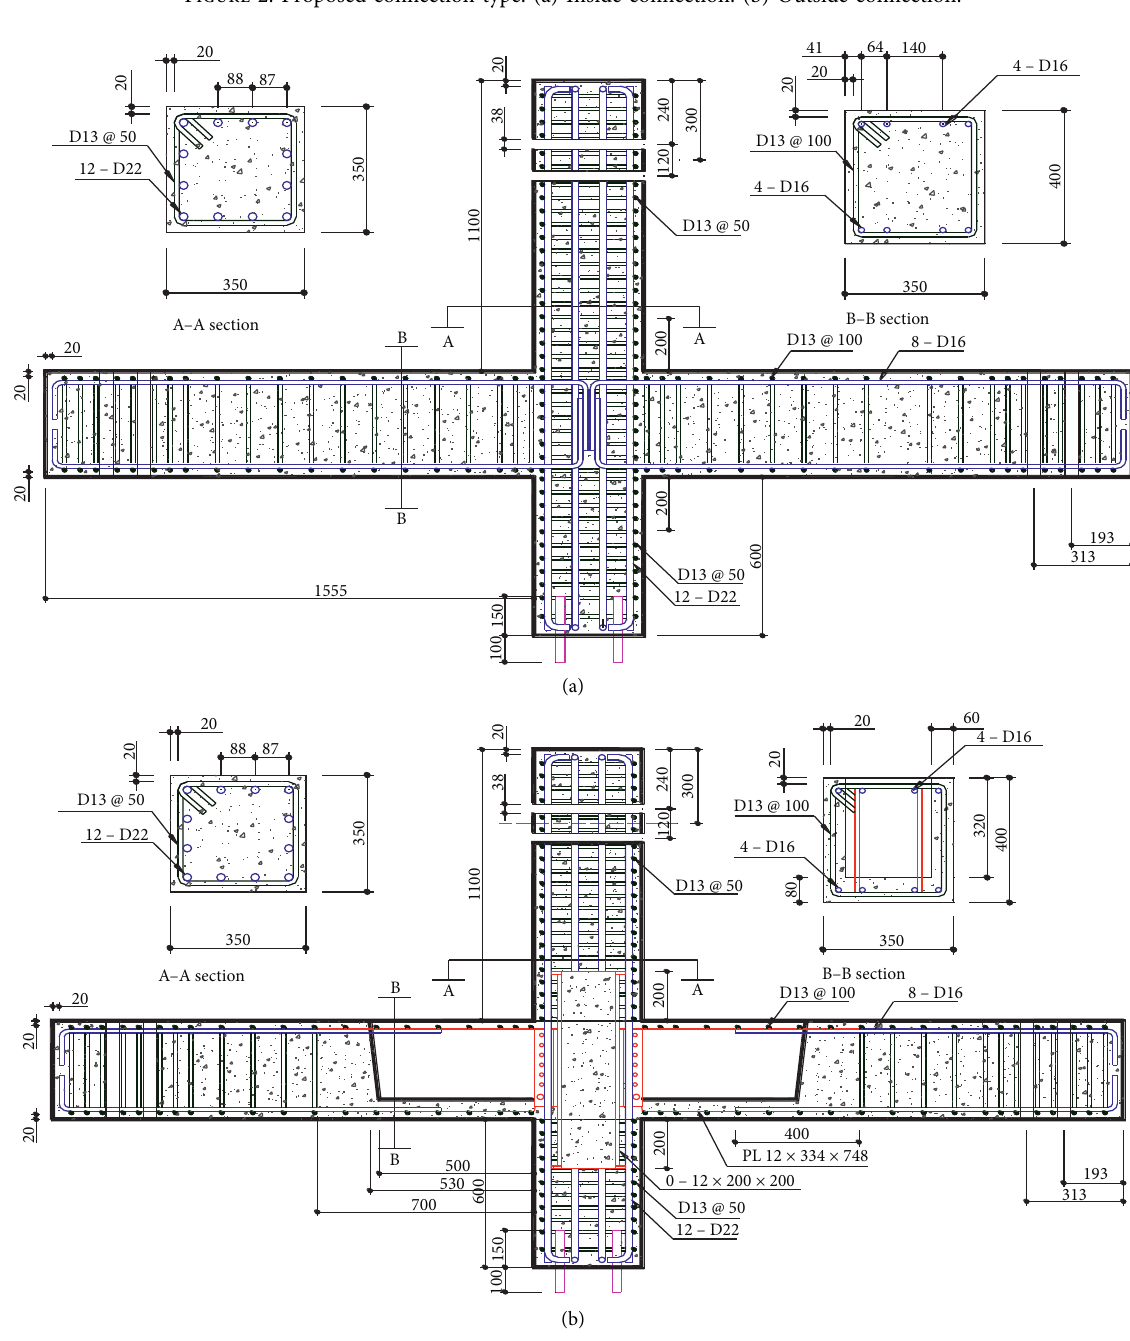
Figure 3: Details of specimens. (a) RC-control. (b) PC-I50-0.2.